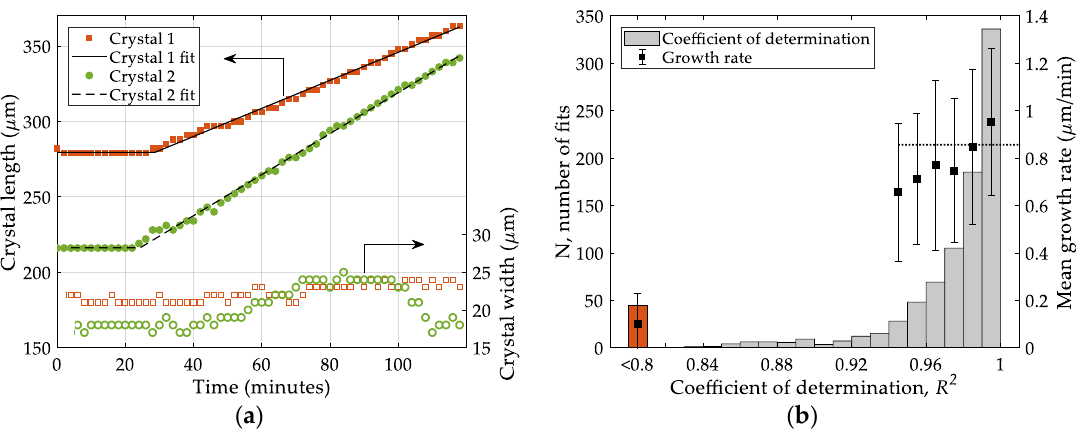
Figure 3. ( a ) The length (left, closed symbols) and width (right, open symbols) of two individual crystals is plotted over time. Note the right axis scale is 5x the left axis scale. Both crystals are fit to Equation (1). ( b ) Left axis, histogram of R 2 values. Right axis, mean growth rate for each bar in the R 2 histogram (with enough samples to compute a meaningful mean and standard deviation, n > 10) with error bars of one standard deviation. Note all bins for R 2 less than 0.8 have been grouped into a single red bin.